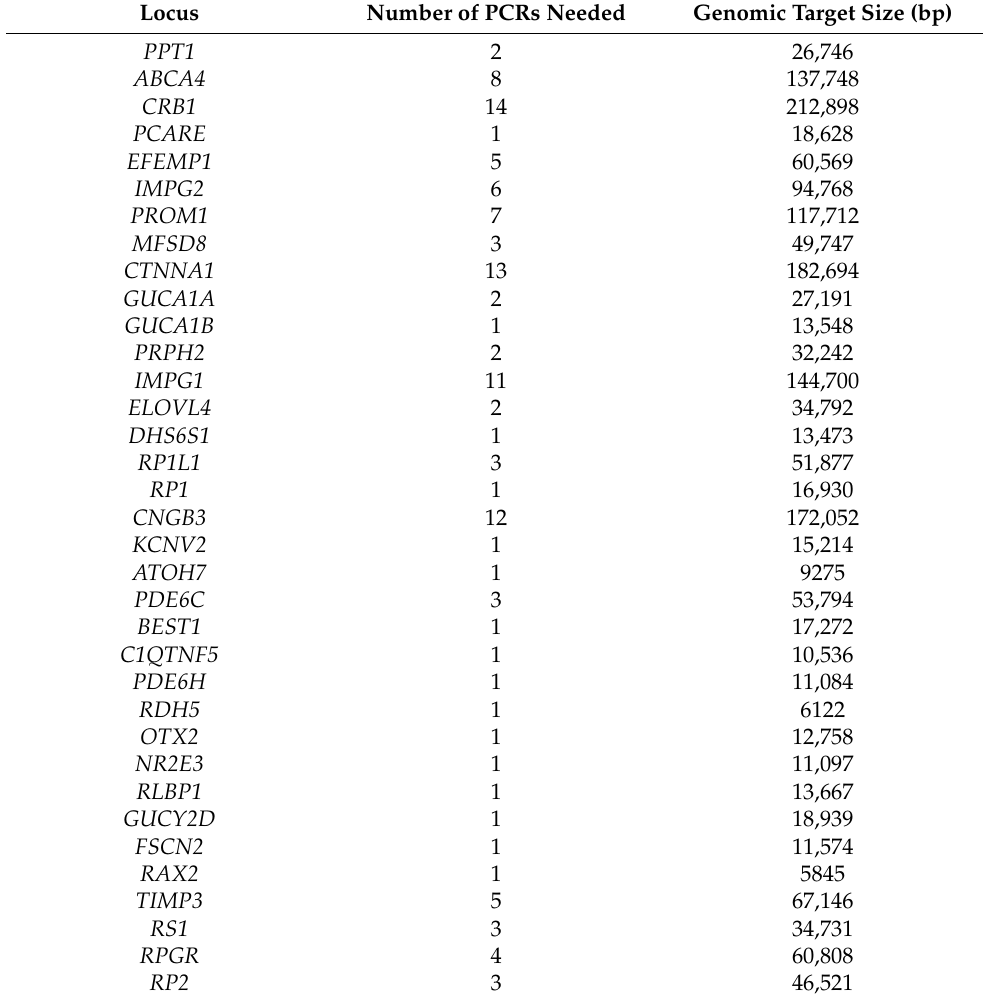
Table 1. Established long-range polymerase chain reactions (PCRs) for retinal diseases-associated loci. The first column indicates the names of the loci included in the panel, ordered by chromosome coordinates. The second column highlights the number of PCRs necessary to cover the locus compre- hensively, and the last column shows the total size of the genomic target sequence. Abbreviations: bp, base pairs.